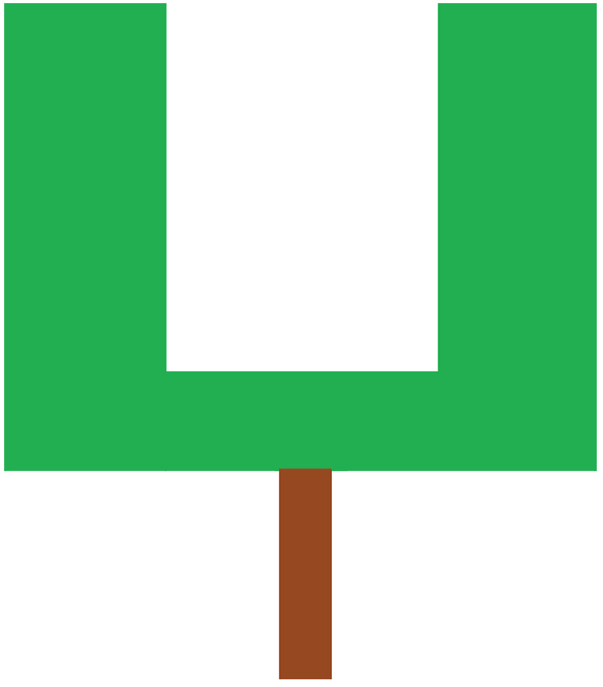
Fig 5. The vase-shaped tree. A simple cross sectional view of the vase-shaped canopy, where the foliage cubes are represented by the green coloured areas and the brown colour area represents the